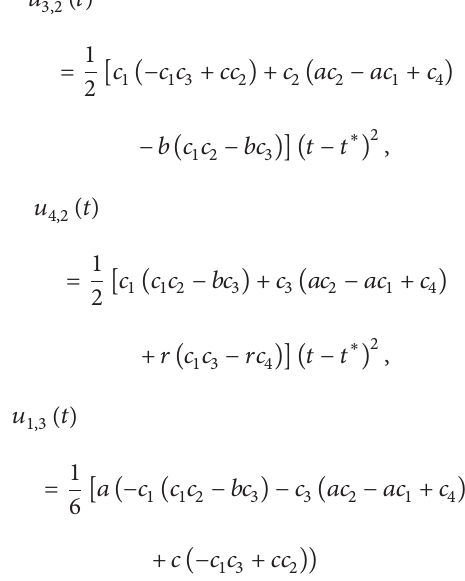
Figure 1: Comparison among 15-term solutions of HPM (solid line), MHPM (circle), and RK4 (dash line) for chaotic L¨u system. Solve for the unknowns of (26) by taking the initial conditions as 𝑢 𝑖,𝑗 (0) = 0, 𝑖, 𝑗 = 1, 2,